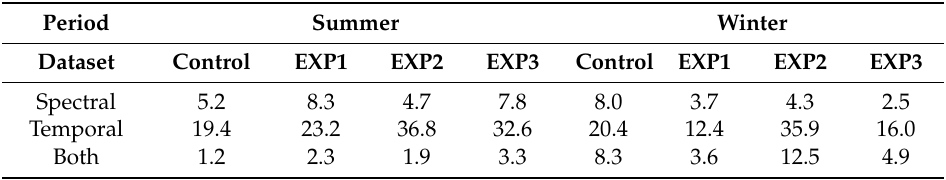
Table 9. The POD scores for the high clouds obtained from the spectral test, the temporal test, and both tests. Note that the sum of the POD values for each experimental dataset equals the POD value of the high clouds given in Figure